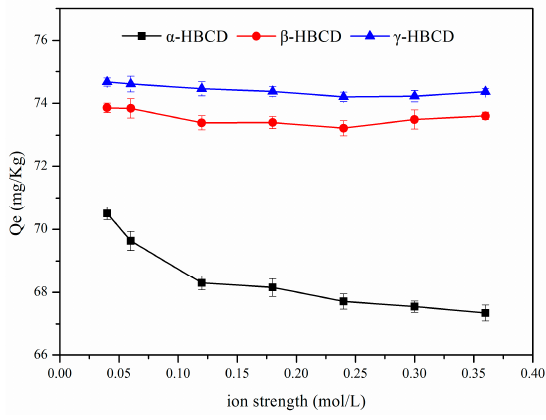
Figure 6. Effects of ion strength on HBCDs sorption in the sediment. Figure 6. E ff ects of ion strength on HBCDs sorption in the